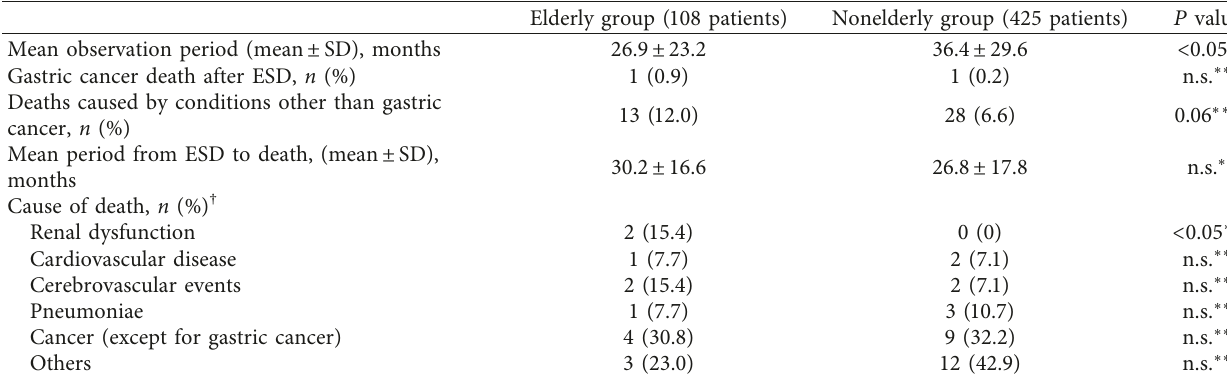
Table 4: Long-term outcomes of endoscopic submucosal